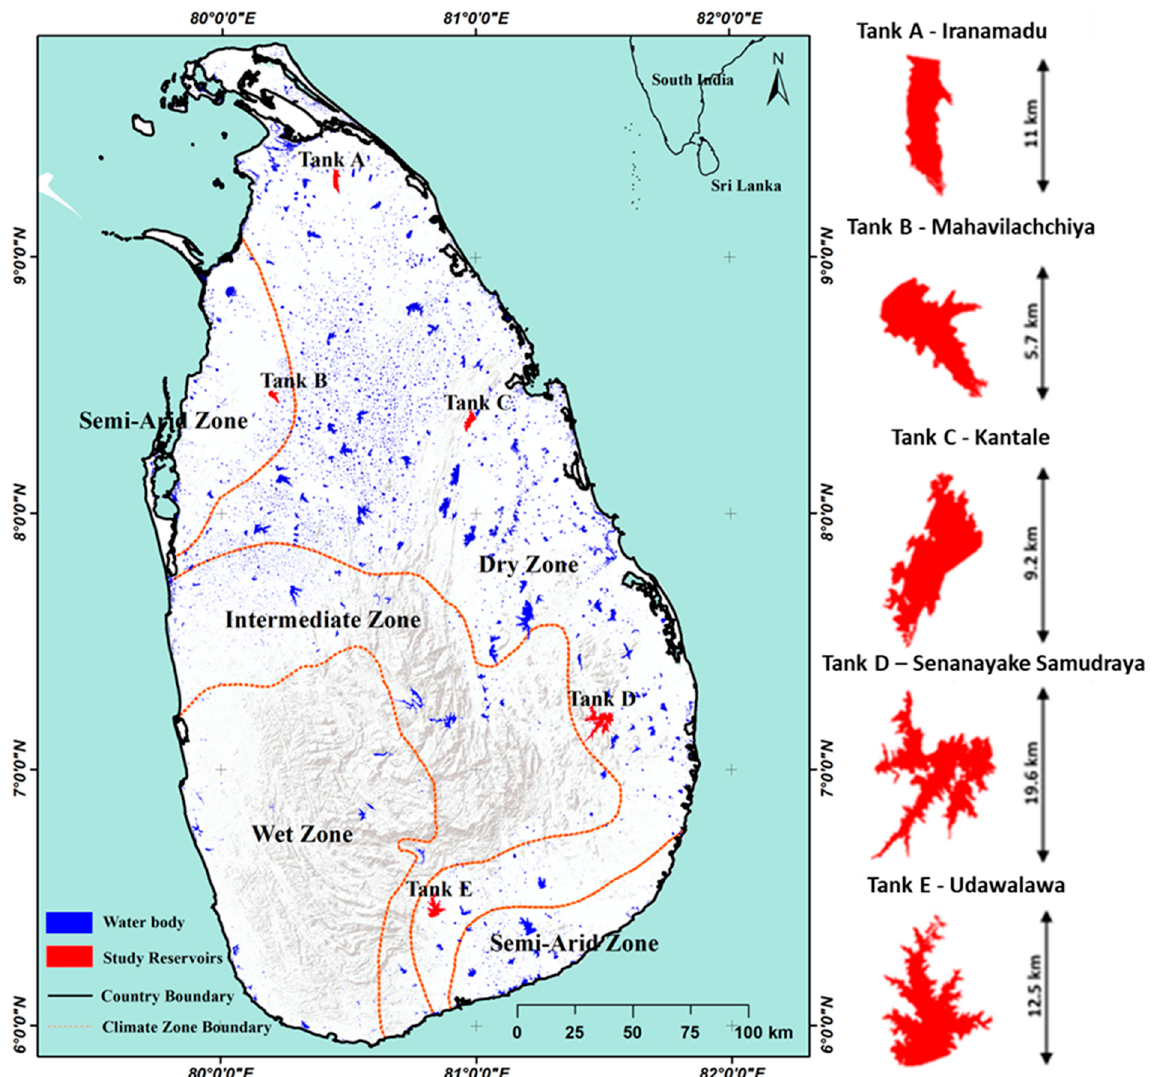
Figure 1. Distribution of five tanks, climatological and topographical, and topographical setting of Sri Lanka. Table 1. Maximum reservoir capacity, surface water area, and maximum depth for selected five tanks. (MCM—Million Cubic Meters) source: Department of Irrigation Sri Lanka.